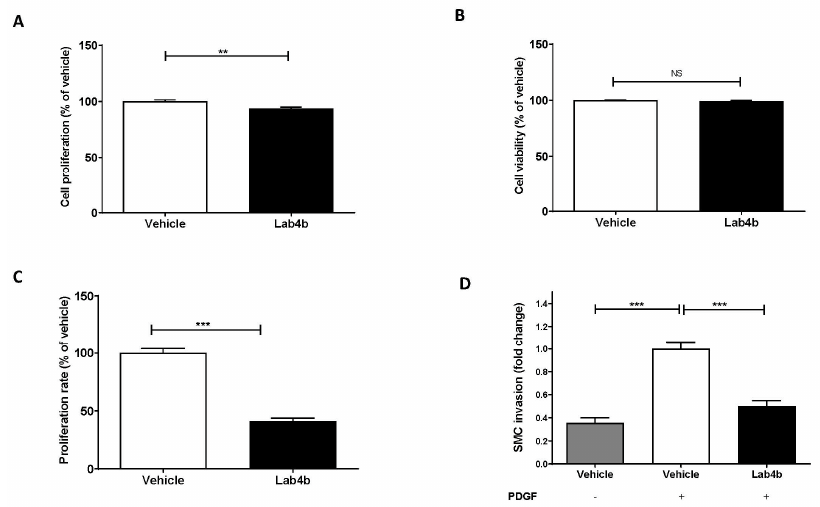
Figure 6. Lab4b CM affects proliferation and migration of HASMC. ( A , B ), HASMC were treated for 7 days with vehicle or 1.5 μ g/mL Lab4b CM and cell proliferation was determined using crystal violet. The supernatant from the same cells was used to determine cell viability by following LDH activity. ( C ), HASMC were treated with vehicle or 1.5 μ g/mL of Lab4b CM for 2 days and the rate of proliferation was determined by BrdU incorporation. The values from Lab4b CM-treated cells are represented in relation to the vehicle control, which was arbitrarily assigned as 100%. ( D ), Invasion of HASMC in response to PDGF (20 ng/mL) was determined following treatment with vehicle or 1.5 μ g/mL of Lab4b CM for 4h. Cells incubated with vehicle in the absence of PDGF were also in- cluded for comparative purposes. The number of migrated cells were counted and averaged per five high-powered field and represented as fold-change to the vehicle control with PDGF, which was arbitrarily assigned as 1. In all cases, data are mean ± SEM from three independent experiments with statistical analysis carried out using an unpaired Student’s t-test ( A – C ) or one-way ANOVA with the Bonferroni post-hoc test ( D ) (**, p ≤ 0.01; ***, p ≤ 0.001; NS, not significant).